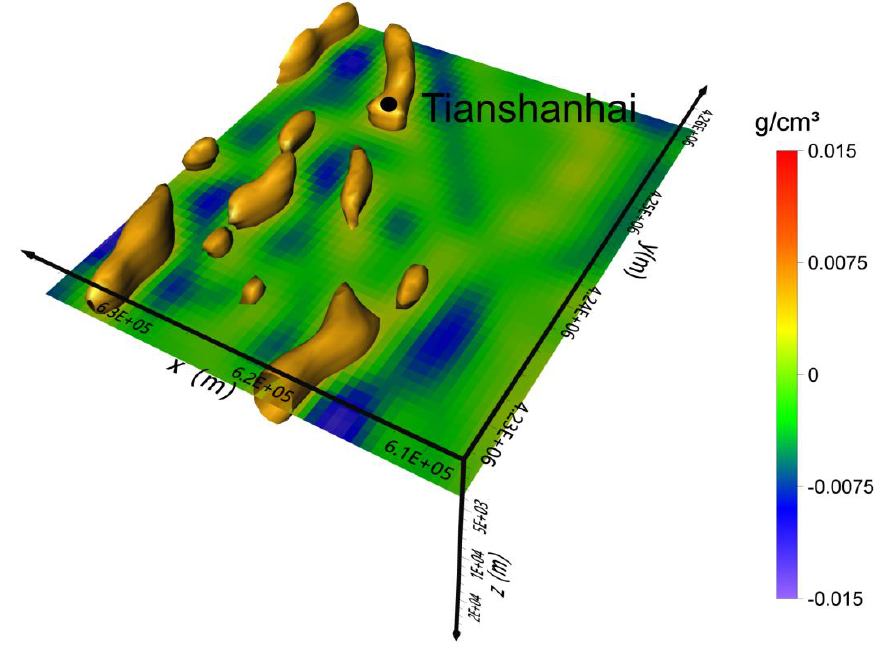
Figure 8. Three-dimensional display of inversion